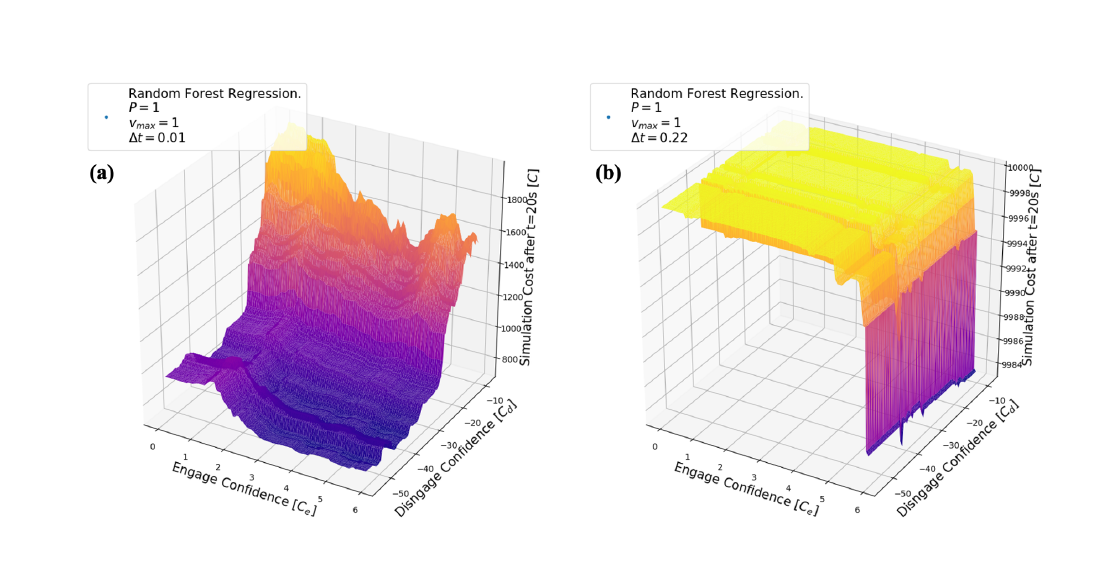
Figure 8. Illustration of 3D cross sections of the 6D best-fit hypercurve for the cost of a simulation obtained using Random Forest Regression. The colormap indicates higher confidence values with warmer (yellower) colors. 3 of the simulation variables ( P , v max , and ∆ t ) were kept constant at the values shown in the legend, while the two others C e and C d were graphed with the equivalent cost in the z -axis. ( a ) Cross section of arbitrarily chosen lower ∆ t value, where cost appears to be at a low value. ( b ) Cross section of arbitrarily chosen higher ∆ t value, where cost appears to be higher on average than ( a ). The minimum vector (cid:126) θ RFRmin for the Random Forest Regression fit was determined in (25) using the previously described method. Its final cost function is C ( (cid:126) θ RFRmin ) = 554.89. A